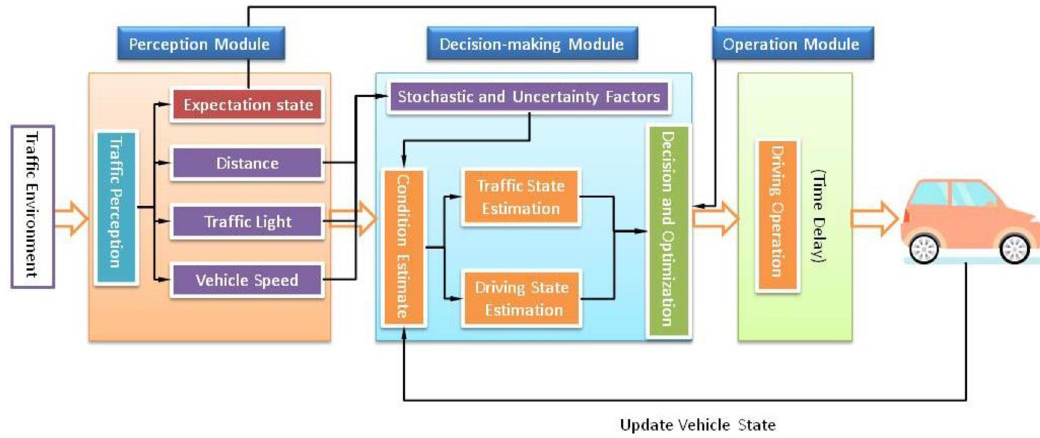
Fig 1. The framework of driving behavior in the dilemma